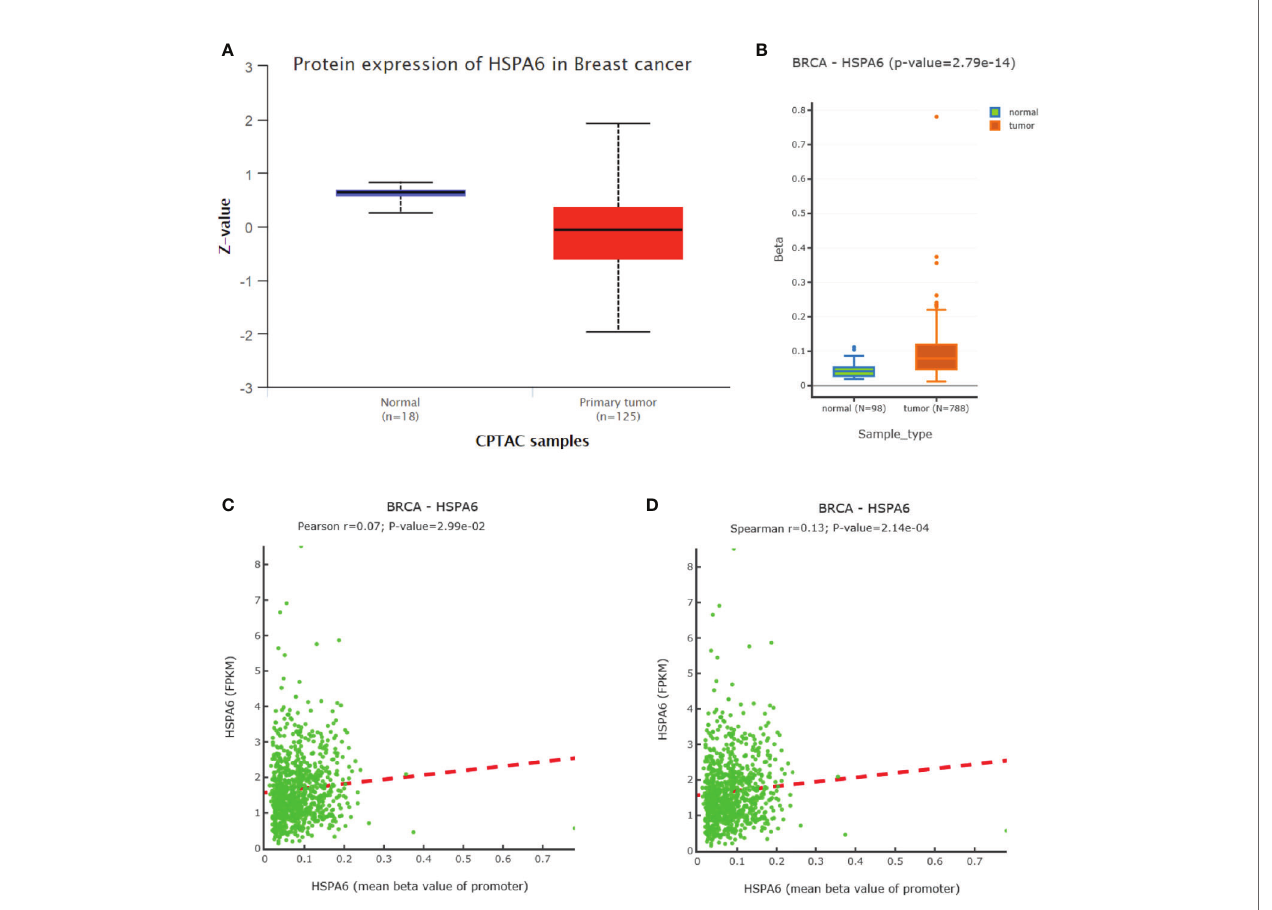
FIGURE 6 | Expression and DNA methylation of HSPA6 in breast cancer tumor tissues. (A) HSPA6 protein levels in normal samples and breast cancer tumors (CPTAC samples) (p<0.01). Z values represent standard deviations from the median across samples in BRCA. (B) Boxplots of DNA methylation for HSPA6 in BRCA (promoter region) (p<0.01). (C) Scatter plots of methylation-expression Pearson correlation for HSPA6 in BRCA. (D) Scatter plots of methylation-expression Spearman correlation for HSPA6 in BRCA. CPTAC, Clinical Proteomic Tumor Analysis Consortium. BRCA, breast invasive carcinoma. Horizontal (X) axes present HSPA6 promoter methylation values whereas vertical (Y) axes present the HSPA6 mRNA expression level (FPKM). FPKM, Fragments Per Kilobase of exon model per Million mapped